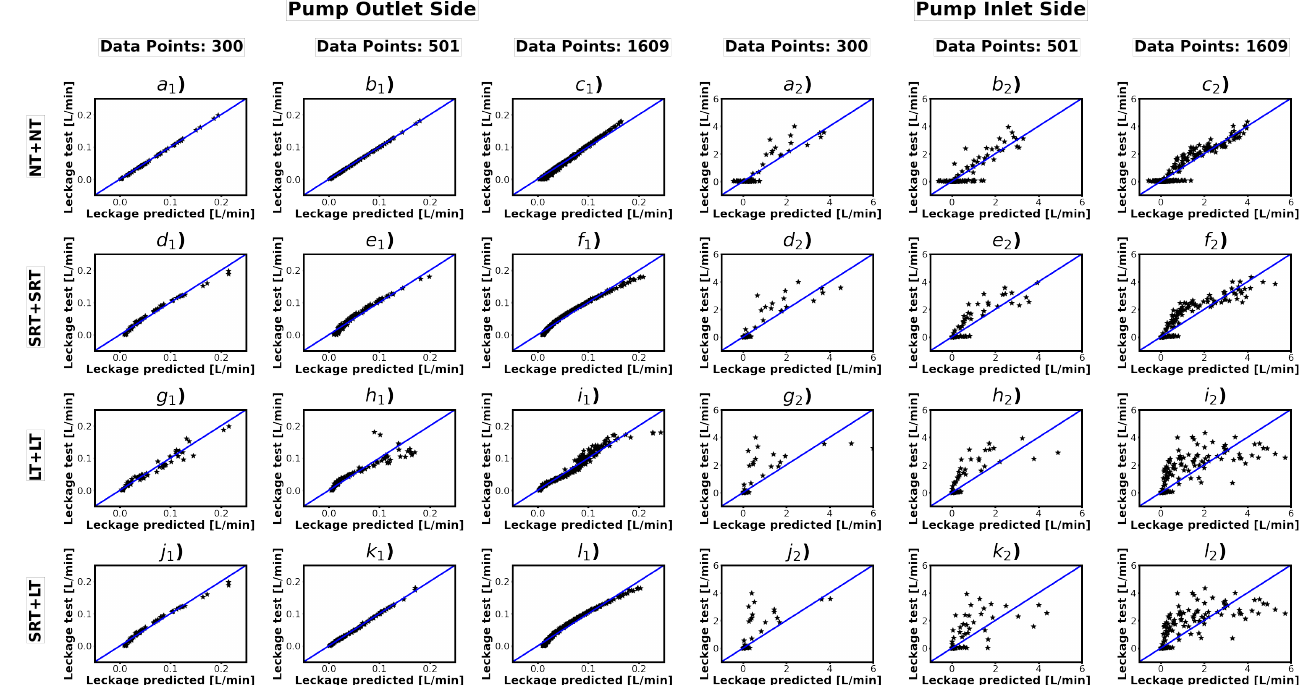
Figure 9. Gaussian Process Regression Test Results Visualization. ( a 1 , 2 ) Model: 300 data points with- out transformation on both sides of the pump. ( b 1 , 2 ) Model: 501 data points without transformation on both sides of the pump. ( c 1 , 2 ) Model: 1609 data points without transformation on both sides of the pump. ( d 1 , 2 ) Model: 300 data points using SRT on both sides of the pump. ( e 1 , 2 ) Model: 501 data point susing SRT on both sides of the pump. ( f 1 , 2 ) Model: 1609 data points using SRT on both sides of the pump. ( g 1 , 2 ) Model: 300 data points using LT on both sides of the pump. ( h 1 , 2 ) Model: 501 data point susing LT on both sides of the pump. ( i 1 , 2 ) Model: 1609 data points using LT on both sides of the pump. ( j 1 , 2 ) Model: 300 data points using SRT on data of pump’s outlet side and LT on data of pump’s inlet side. ( k 1 , 2 ) Model: 501 data points using SRT on data of pump’s outlet side and LT on data of pump’s inlet side. ( l 1 , 2 ) Model: 1609 data points using SRT on data of pump’s outlet side and LT on data of pump’s inlet